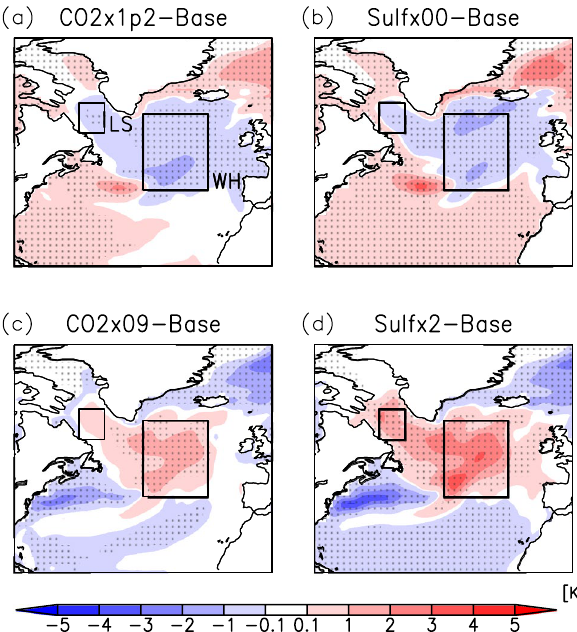
Figure 2. Anomalies of the annual mean sea surface temperature for CO2 × 1p2 ( a ), Sulf × 00 ( b ), CO2 × 09 ( c ), and Sulf × 2 ( d ) experiments from the base experiment in the North Atlantic. Areas of dots indicate that the change is statistically significant. LS and WH show the Labrador Sea and NAWH regions, respectively. The maps were generated with GrADS 2.2.1 (URL: http:// cola. gmu. edu/ grads/).